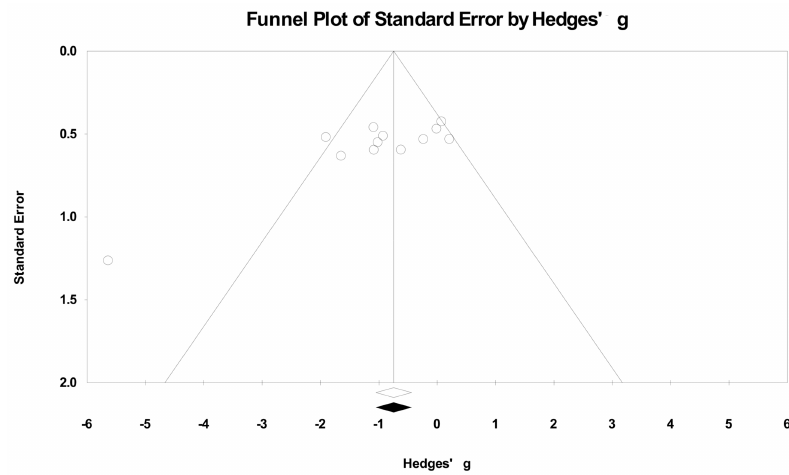
Figure 5. Funnel plots of standard error by Hedges’ g of blood glucose levels in DM rodents treated with or without rooibos extracts or major phenolic compounds. Open and closed diamond indicates the imputed summary estimates before and after Duval and Tweedie’s Trim and Fill adjustment (random-effects models), respectively. No imputed studies were found in re-displayed funnel plots by Duval and Tweedie’s Trim and Fill